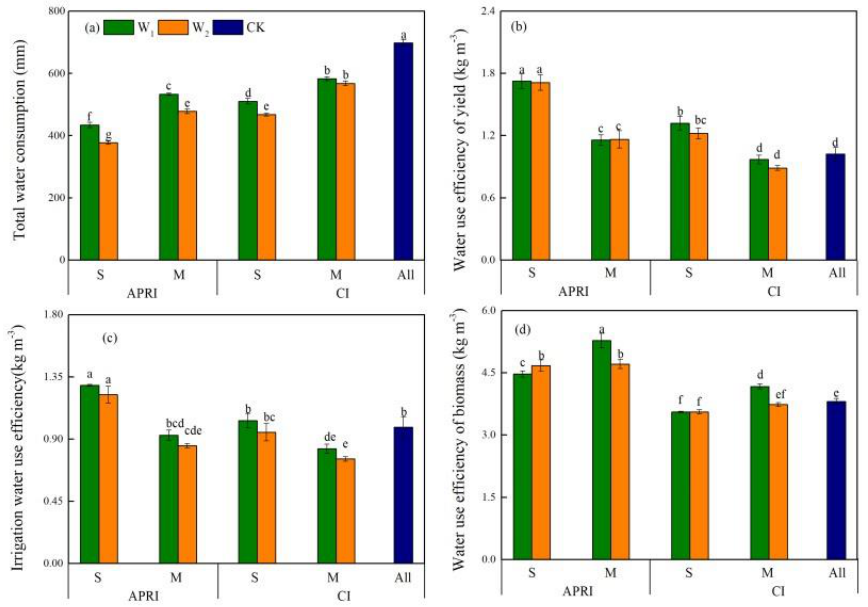
Figure 7. Effects of different irrigation levels and deficit stages on the ET ( a ), WUE Y ( b ), IWUE ( c ), and WUE B ( d ) of maize under alternate partial root-zone irrigation. Different letters on top of the bar denote significant differences at p < 0.05 according to the Duncan